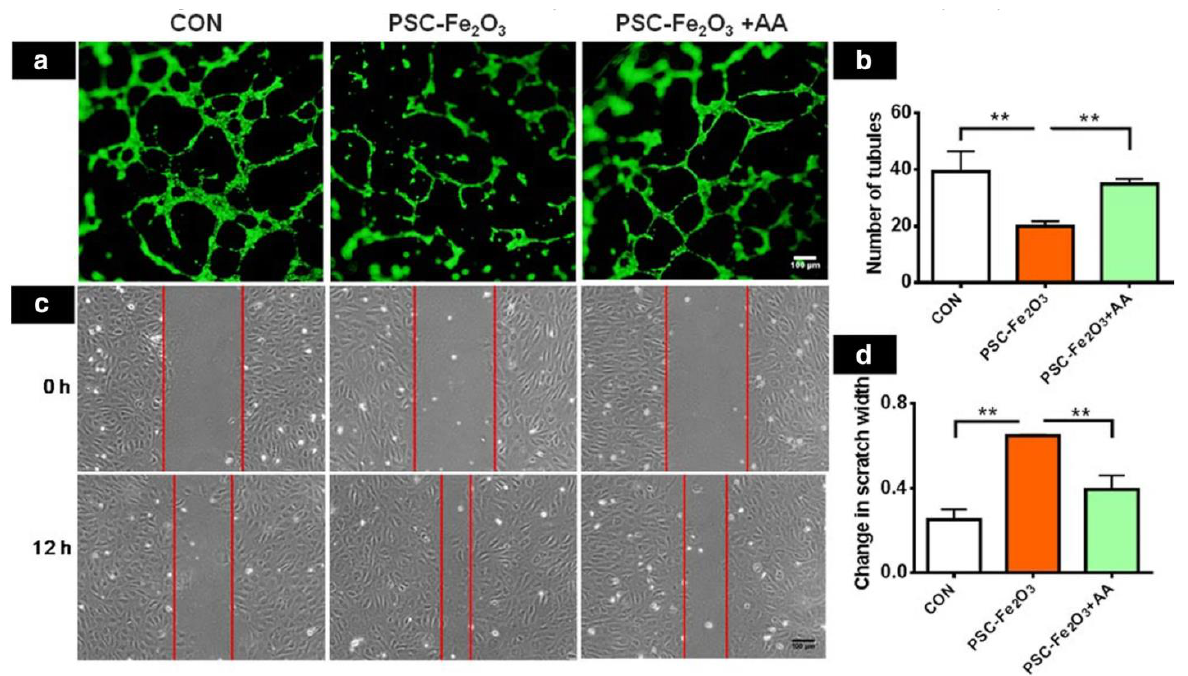
Figure 5. ROS scavenger AA conversed the function of endothelial cells happening EndMT. ( a ) AA conversed tubule production impairment of endothelial cell caused by PSC-Fe 2 O 3 . ( b ) measurement of endothelial meshes ( n = 3). ( c ) pictures of scratch morphology altering with time. ( d ) Relative scratch width alteration ( n = 2). Data are mean ± SD, one-way ANOVA with LSD-t, ** p < 0.01 [139].